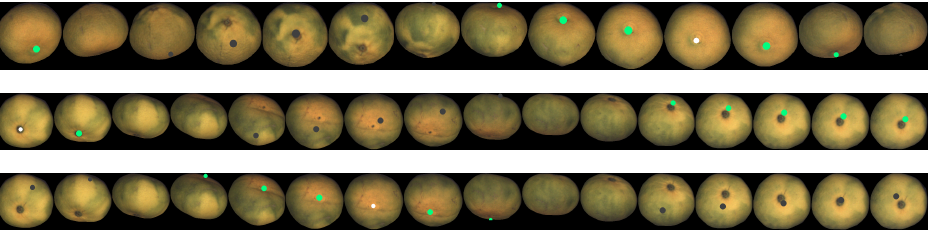
Figure 27. Example of point tracking in the case of three different mandarins. Dark circles mean predicted occluded positions of the initial point. The third row is the same fruit as the second, but a different point is tracked. Oblate geometry has been used.